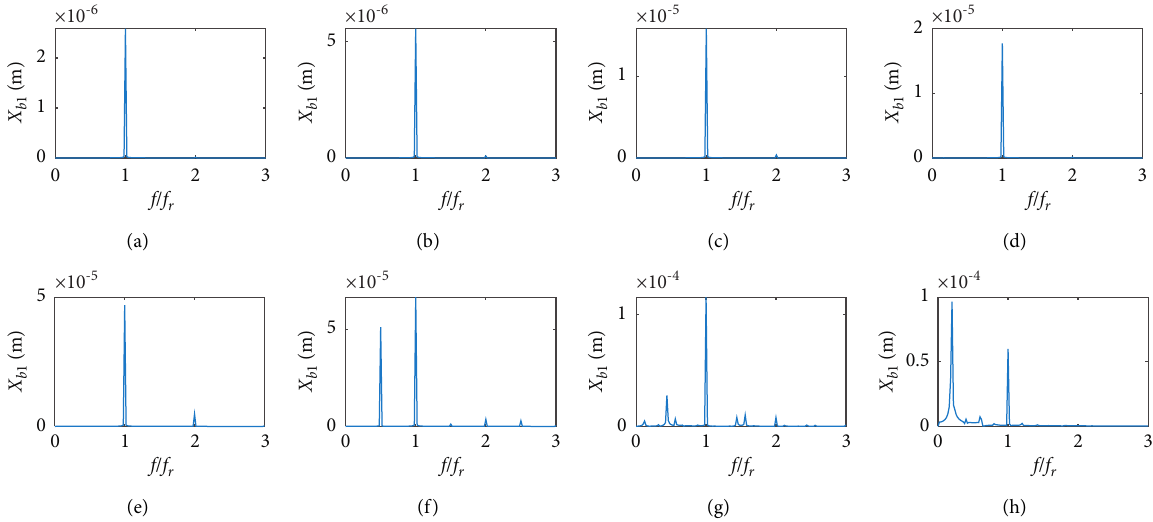
Figure 6: Spectrum diagram: (a) normal state, 2000rpm; (b) normal state, 5000rpm; (c) normal state, 8000rpm; (d) normal state, 18000rpm; (e) fault state, 2000rpm; (f) fault state, 5000rpm; (g) fault state, 8000rpm; (h) fault state, 18000rpm.